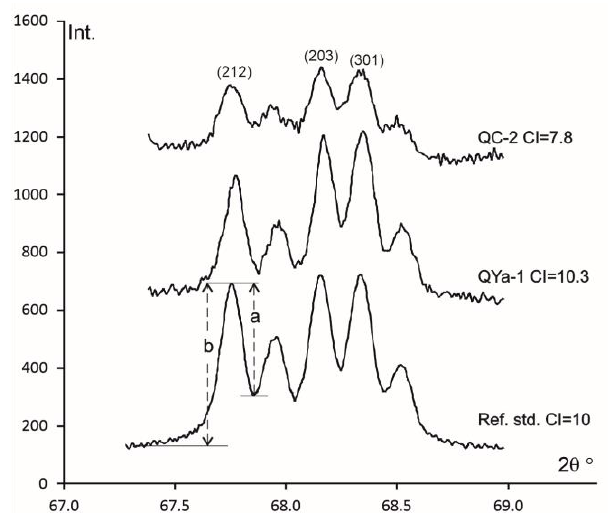
Figure 7. Diffractograms from chalcedony (QC-2, Suisari island), quartz (QYa-1, Yalguba Ridge), and quartz crystal (Ref. std., Subpolar Urals) of the 2 θ ≈ 68 ◦ quintuplet. a and b parameters are measured for Crystallinity Index (CI) calculation.